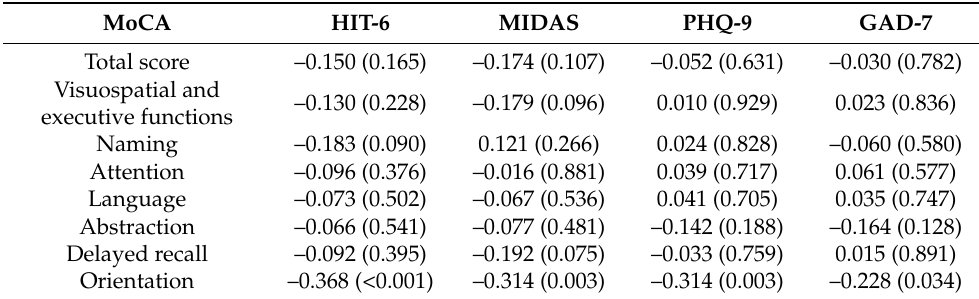
Table 7. Correlations of cognitive function with the degree of headache-related disability and psychological symptoms ( r value ( p value)).